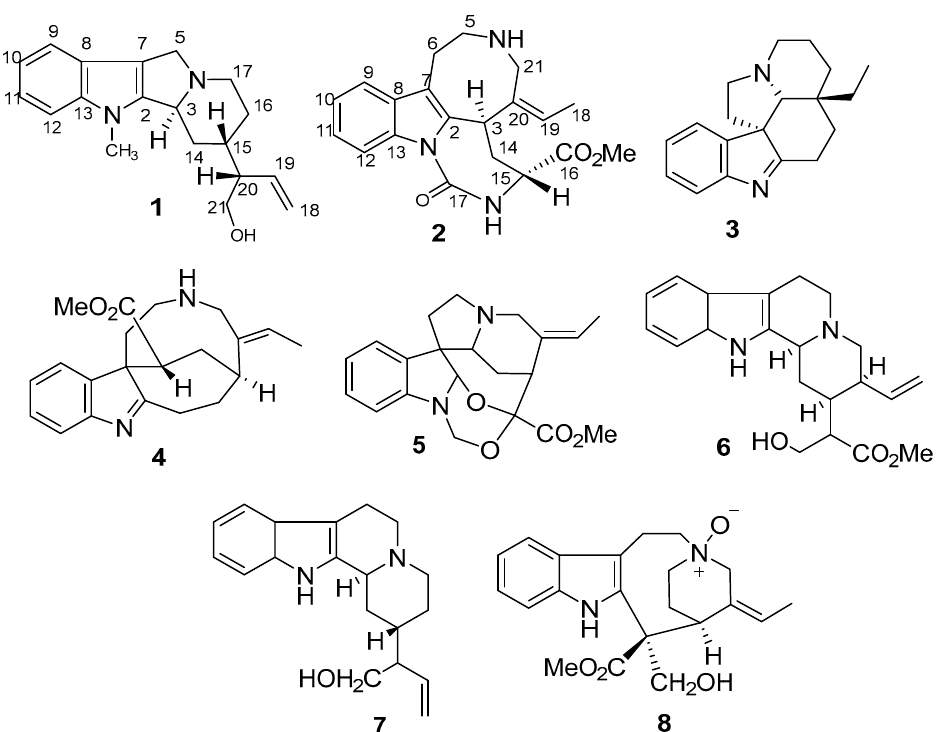
Figure 1. Compounds isolated from the aerial parts of Rhazya stricta .